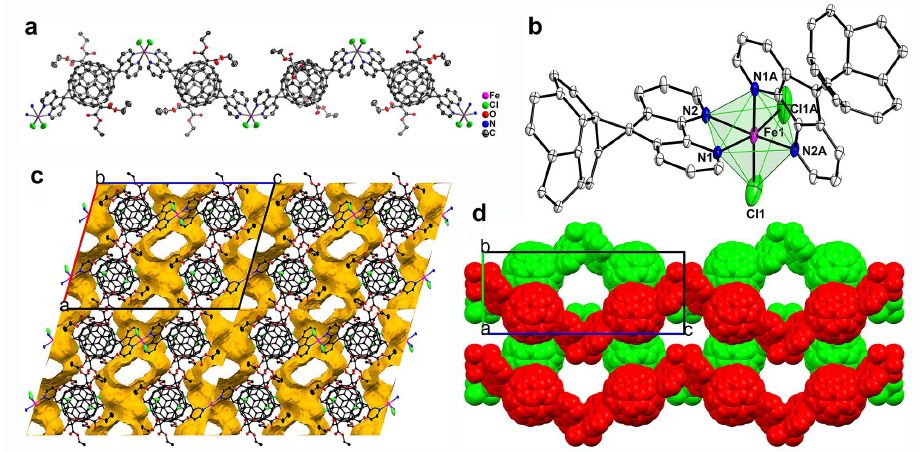
Figure 6. ( a ) 1D zigzag chain structure viewed down the a -axis in 5 . Front and back malonate addends and all hydrogen atoms were omitted for clarity; ( b ) coordination environment of Fe(II) cation; ( c ) voids between chains shown along the b- axis; ( d ) interlayer relationship within the crystal lattice as seen from the a -axis; hydrogen atoms and malonate addends have been omitted for clarity. As a comparison, trivalent FeCl 3 · 6H 2 O was adopted to assemble with L1 as well.